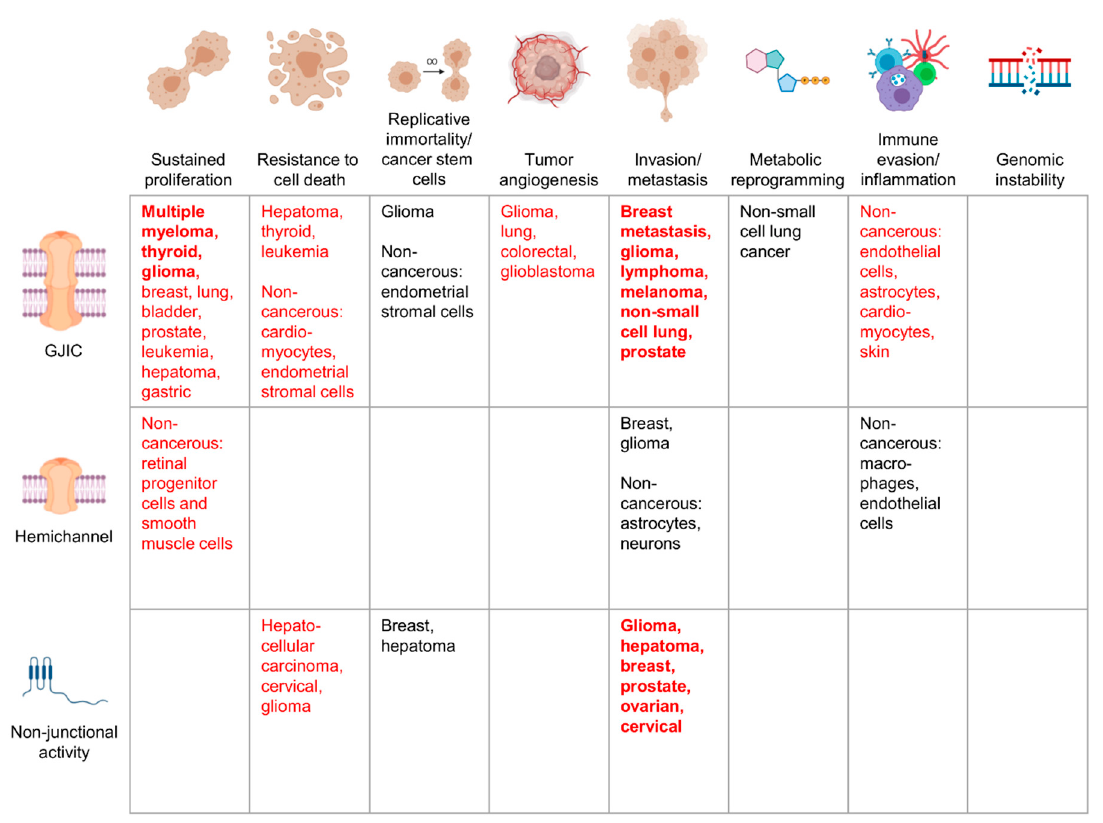
Figure 1. Cancers in which specific connexin functions have been described to be pro-tumorigenic. Schematic showing examples of the cancer types in which pro-tumorigenic properties have been attributed to a specific connexin function, whether gap junction intercellular communication (GJIC), connexin hemichannels, or a non-junctional function. Bold red text indicates strong evidence from many cancer types tying the connexin function to the corresponding cancer hallmark, with red text indicating a less robust link and black text indicating emerging evidence. Where mechanistic studies in cancer cells are not available, certain non-transformed cell populations are indicated. References for the indicated cancers are provided in the text. Figure illustrations generated using BioRender.com.